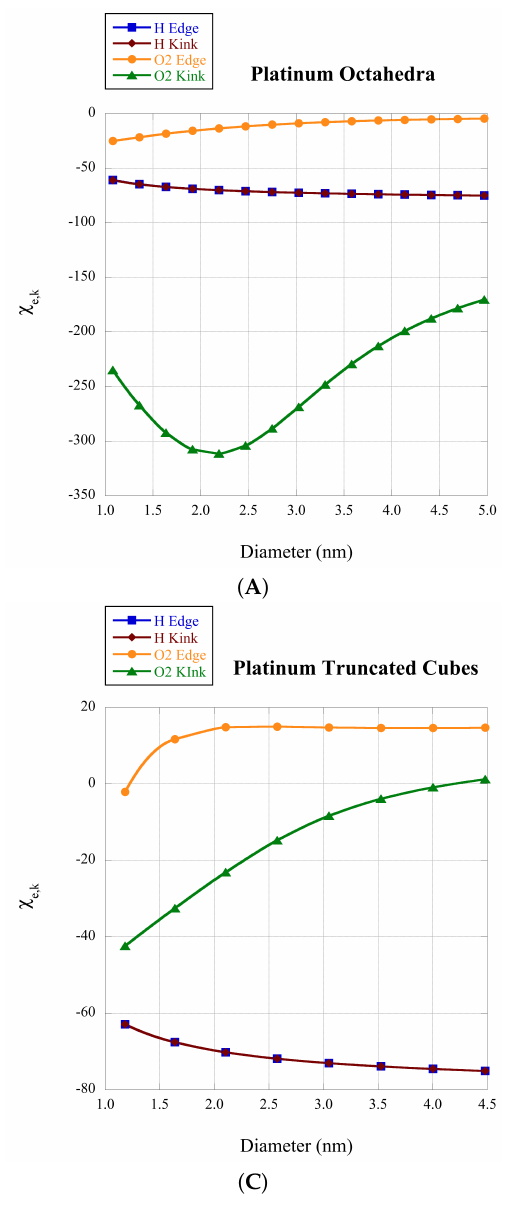
Figure 2. Plots of χ e and χ k versus D for the four polyhedra. In all four plots, the data for H-Edge and H-Kink overlap on the scale presented. ( A ) octahedra; ( B ) cuboctahedra; ( C ) truncated cubes; ( D )